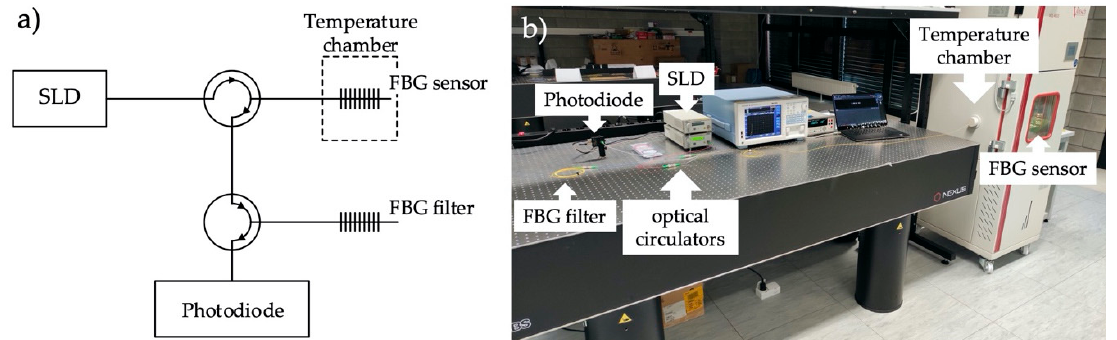
Figure 7. Scheme ( a ) and picture ( b ) of the experimental stand for testing the transfer characteristics of the fiber Bragg grating